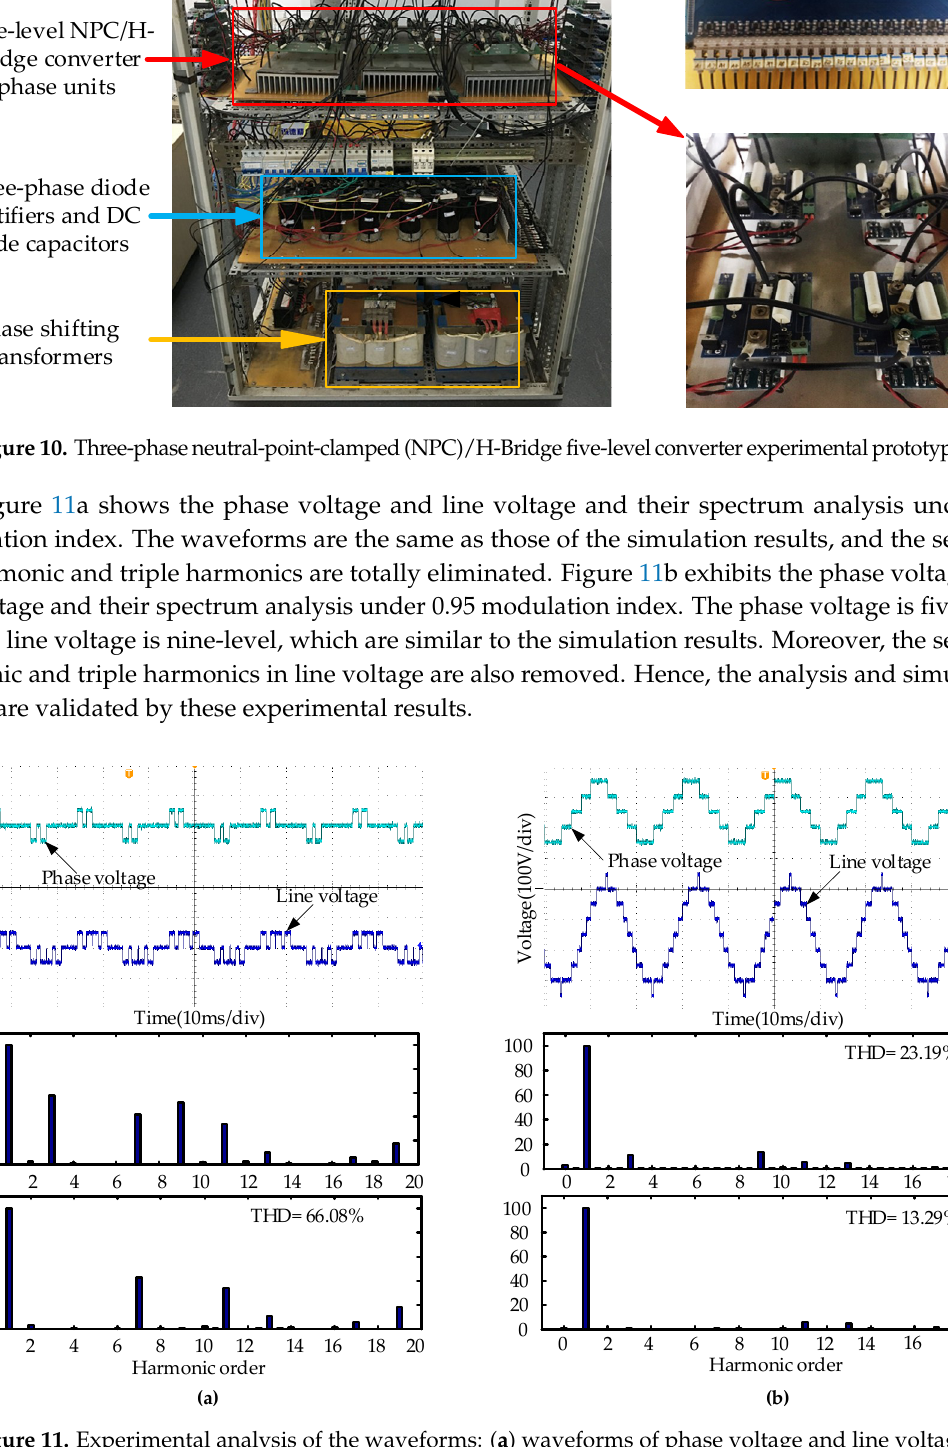
Figure 11. Experimental analysis of the waveforms: ( a ) waveforms of phase voltage and line voltage and their spectrum analysis under a modulation index of 0.2; ( b ) waveforms of phase voltage and line voltage and their spectrum analysis under a modulation index of 0.9.